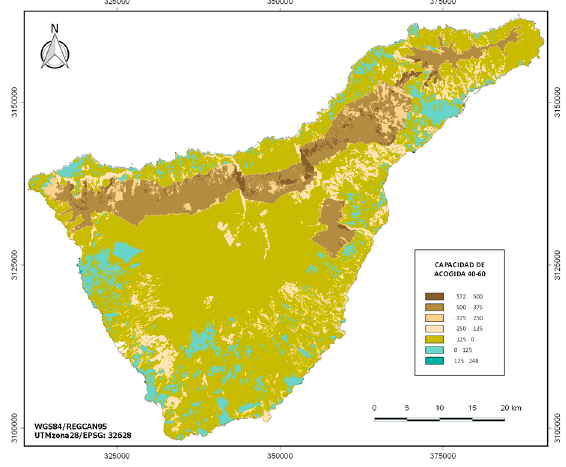
Figure 4. Provisional Model of Reception Capacity: CA 60-40 ( top left ), CA 50-50 ( top right ) and CA 40-60 ( down ).